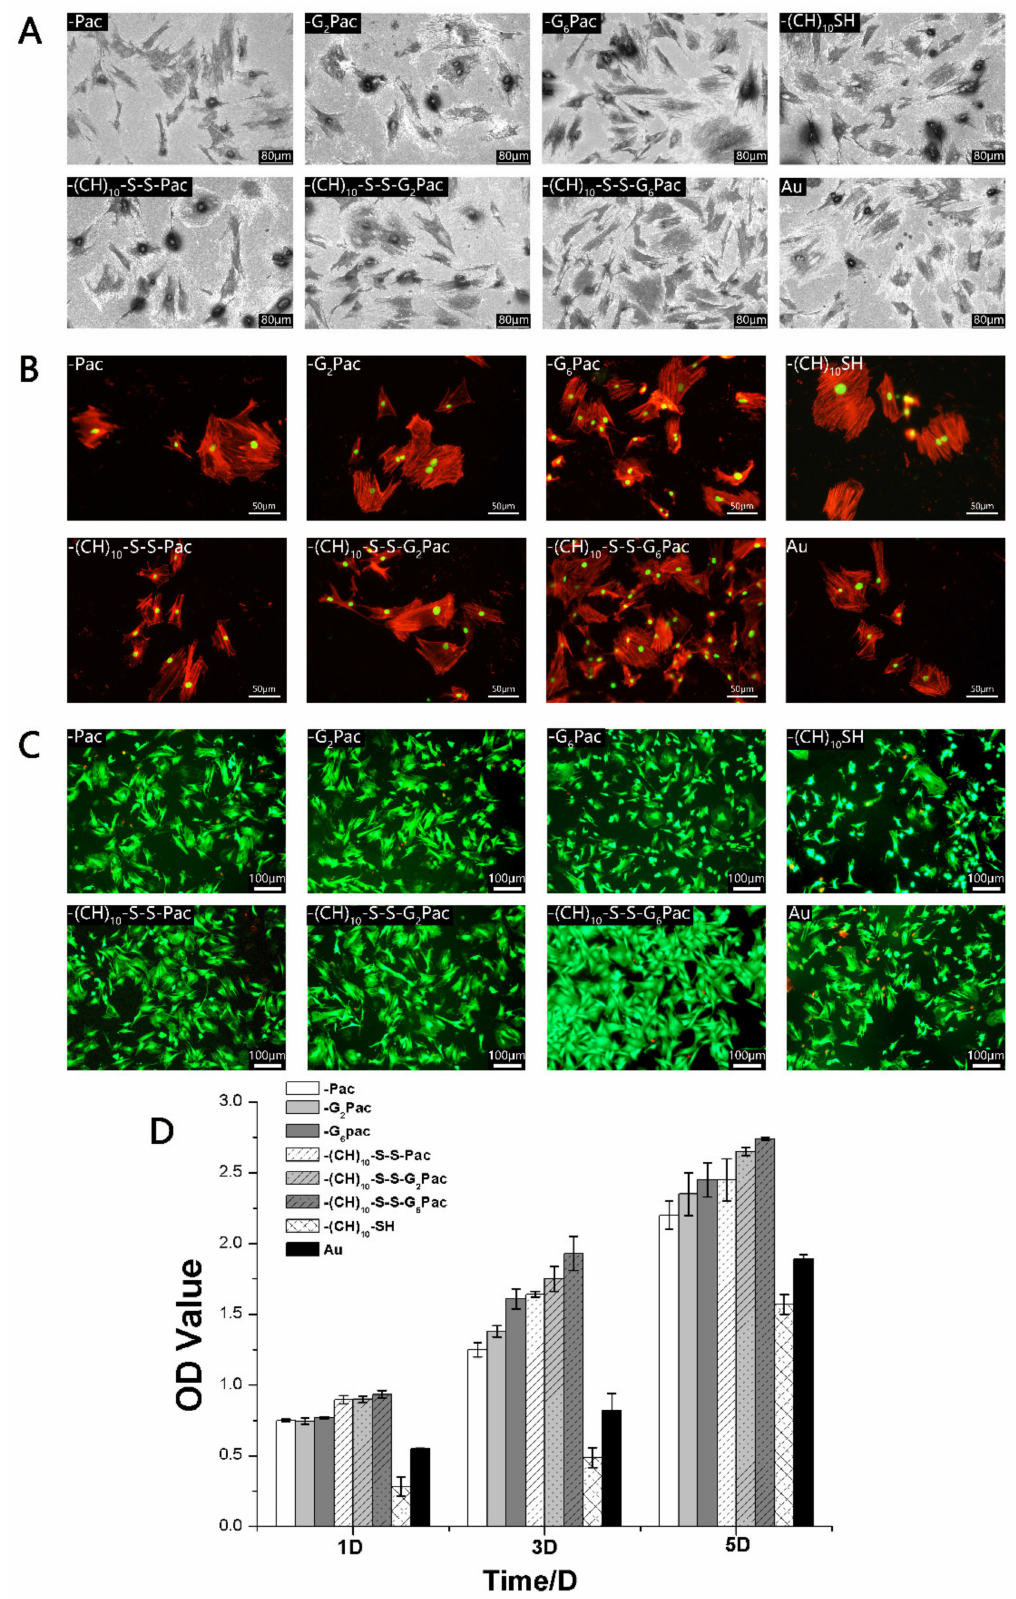
Figure 7. The biocompatibility of the SAM substrates evaluated by in vitro cell culture of rBMSCs. ( A ) Typical SEM images of rBMSCs on different substrates; ( B ) CLSM images of rBMSCs stained with Rhodamine Phalloidin for F-actin (red) and SYTOX Green for nuclei (green); ( C ) live/dead fluorescence images of rBMSCs after 48 h of cell culturing, green for live cells and red for dead cells; ( D ) cell proliferation of rBMSCs within one week by CCK-8